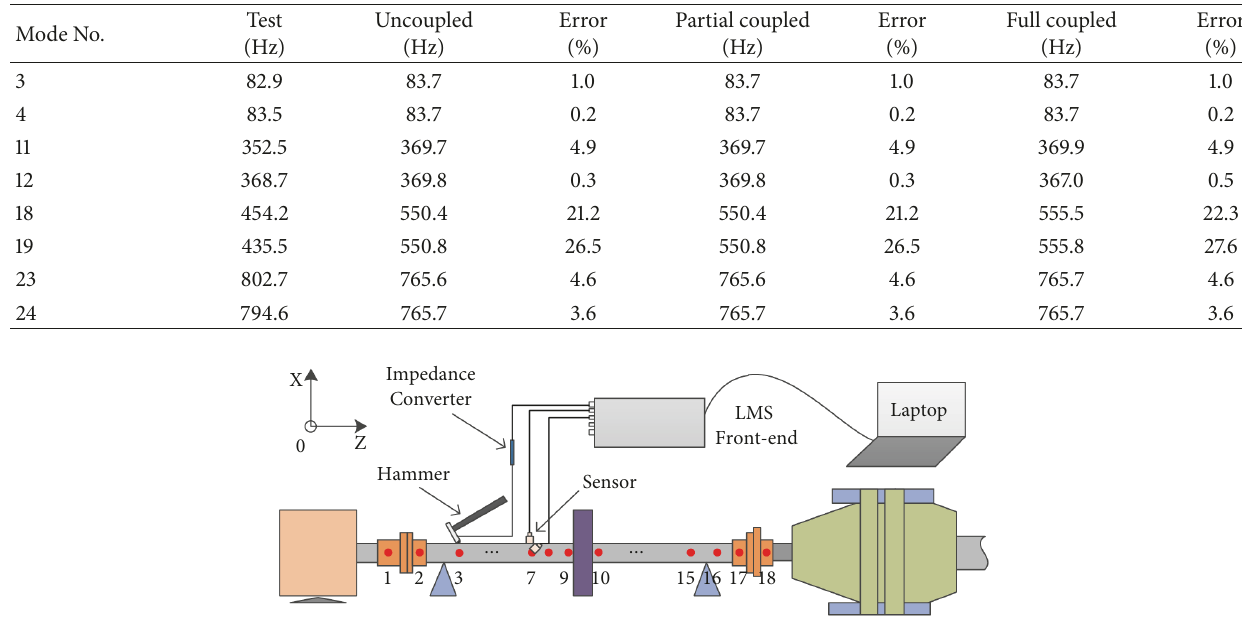
Table 6: Comparison of the lateral natural frequencies between calculation and test. Mode No.